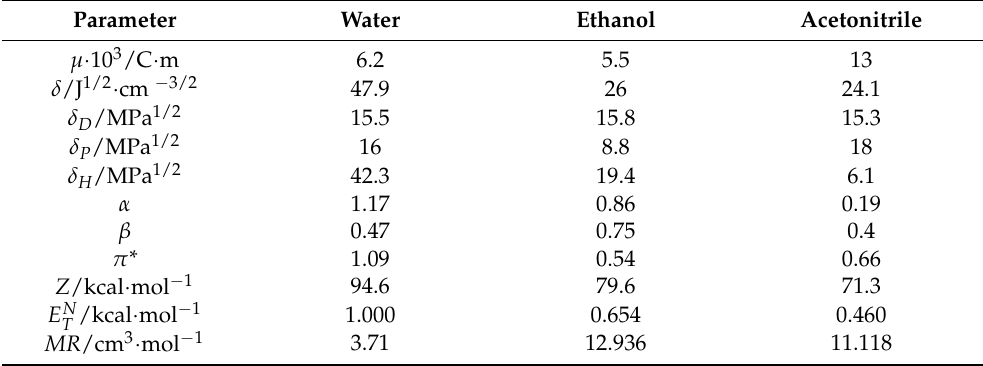
Table 4. Values of the parameters used ( T = 298 K) to describe the three solvents (water, ethanol, and acetonitrile).